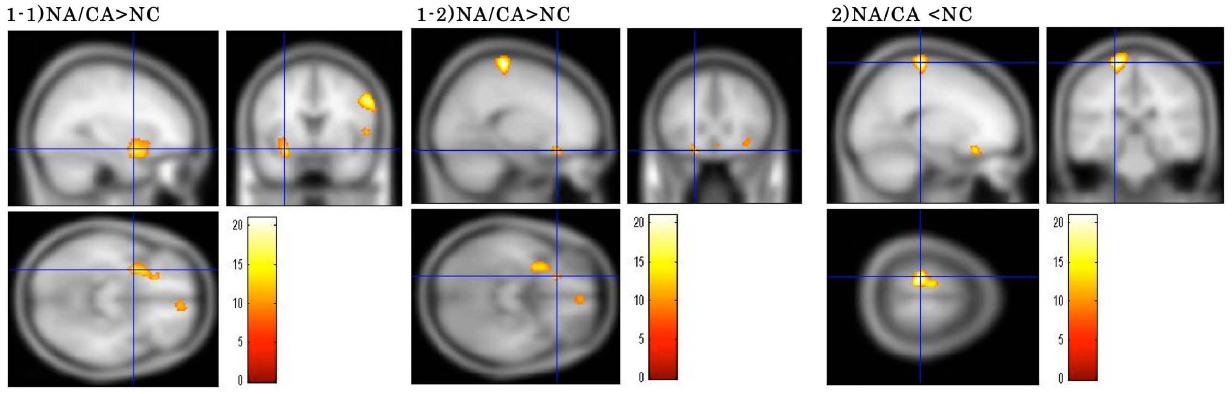
Figure 1. Clusters showing significant main effects of group on ADC value between patients having narcolepsy with cataplexy (NA/ CA) and normal control (NC). 1-1) ADC values were higher in the left parahippocampal gyrus (Brodmann area 34) and amygdala, and 1-2) in the left inferior frontal gyrus (Brodmann area 47/11) in NA/CA than in NC, while these values were lower in 2) the left postcentral gyrus (Brodmann area 3) in the former group. pone.0081059.Results.tifare significant at FWE-corrected p , 0.05. Color scale is for F statistic.